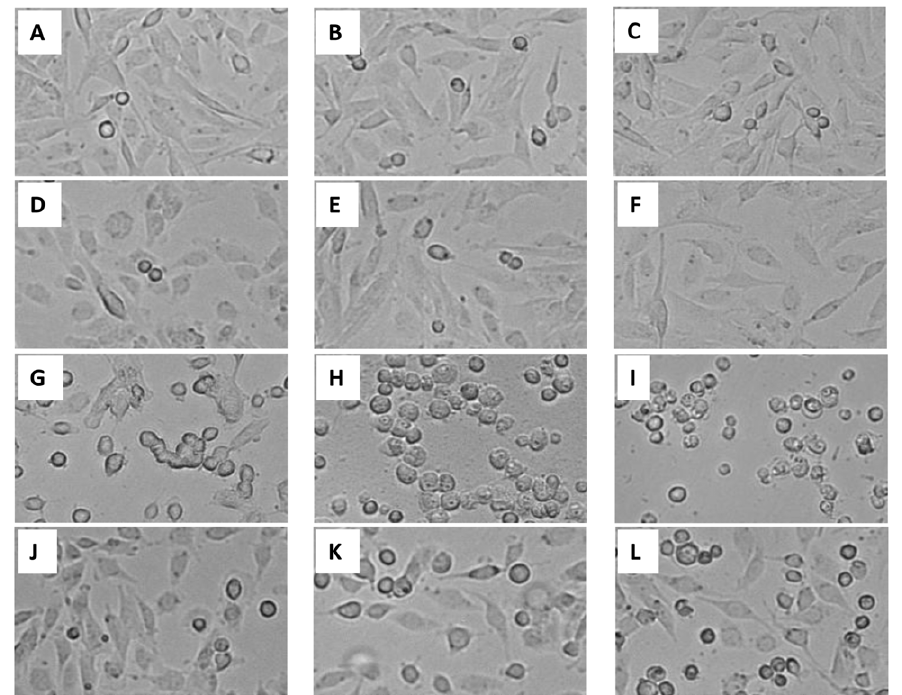
Figure 3. Effect of H258 on morphological changes induced by H342 in H2373 cells. H2373 mesothelioma cells were treated with H342 or H258 alone, or combination of H342 + H258 for different times. Control: A (1h), B (3h) and C (6h); 36 m M H258-treated: D (1h), E (3H), F (6h); 36 m M H342-treated: G (1h), H (3h), I (6h); 36 m M H258- and 36 m M H342-treated: J (1h), K (3h), L (6h).